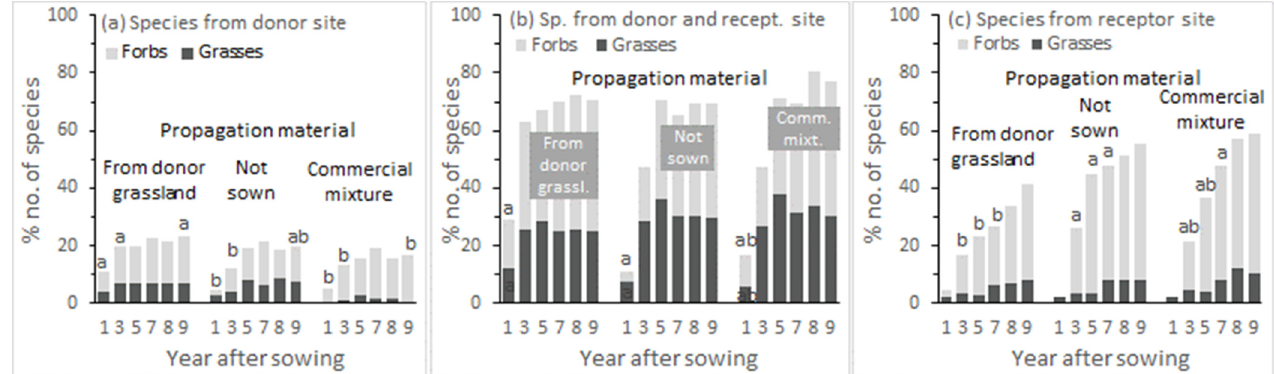
Figure 3. Time pattern of the percent number of species (total, grasses, and forbs) ( a ) from the donor site grassland ( Nardo-Agrostion) , ( b ) from both the donor and receptor site, and ( c ) only from the receptor site established in 25 m 2 plots of a ski slope grassland restoration experiment. The total species numbers were 42 in ( a ), 24 in ( b ), and 48 in ( c ). In each graph, letters above the bars show the result of the among-propagation material comparison separately for each year. Means with common letters do not differ at p ≤ 0.05.